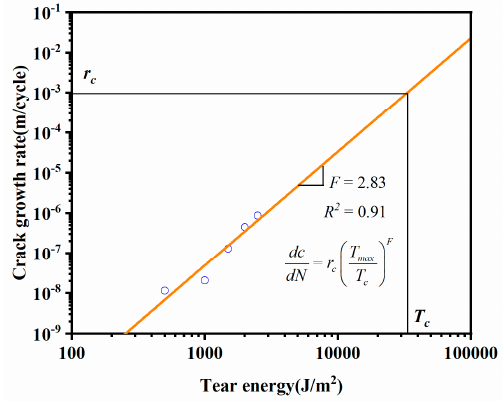
Figure 12. Fitting curve of crack growth rate and tear energy.